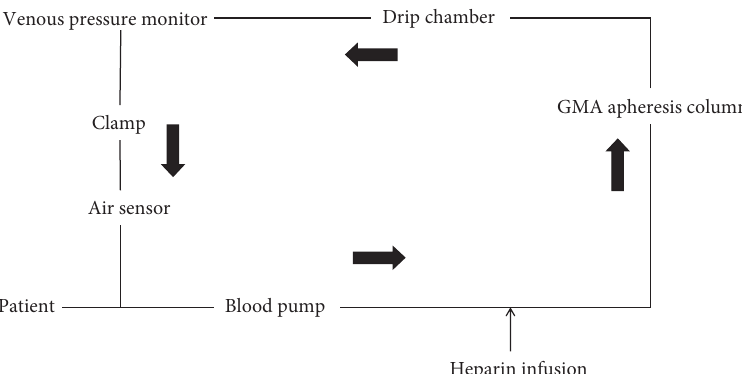
Figure 2: Circuit of granulomonocytapheresis with the single-needle method. Black arrow represents the blood